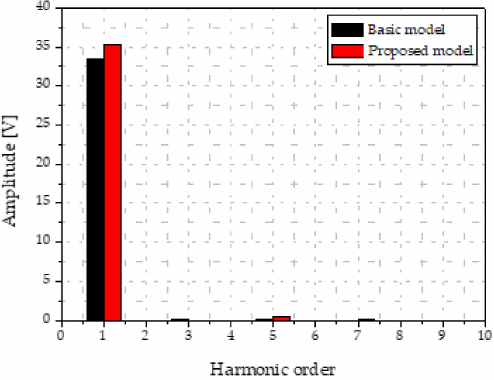
Figure 11. Characteristics of total harmonic distortion (THD) of the back EMF waveforms.